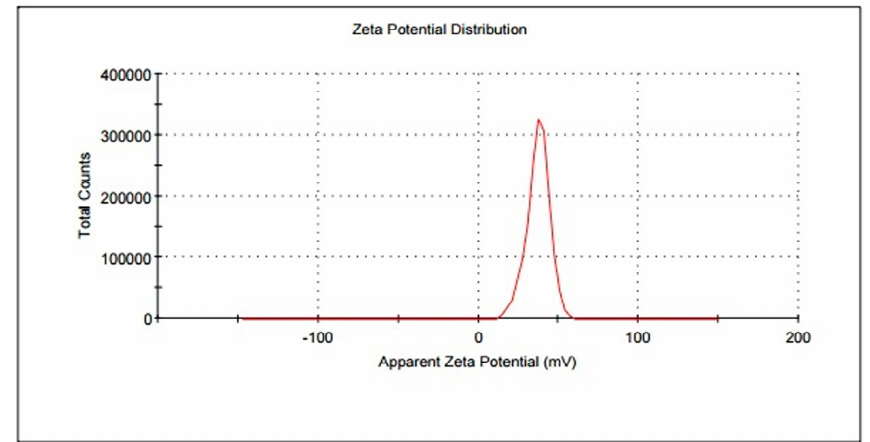
Figure 9. Zeta potential distribution of PEG-coated Fe 3 O 4 nanoparticles of sample S2 using deionized water as the dispersant.